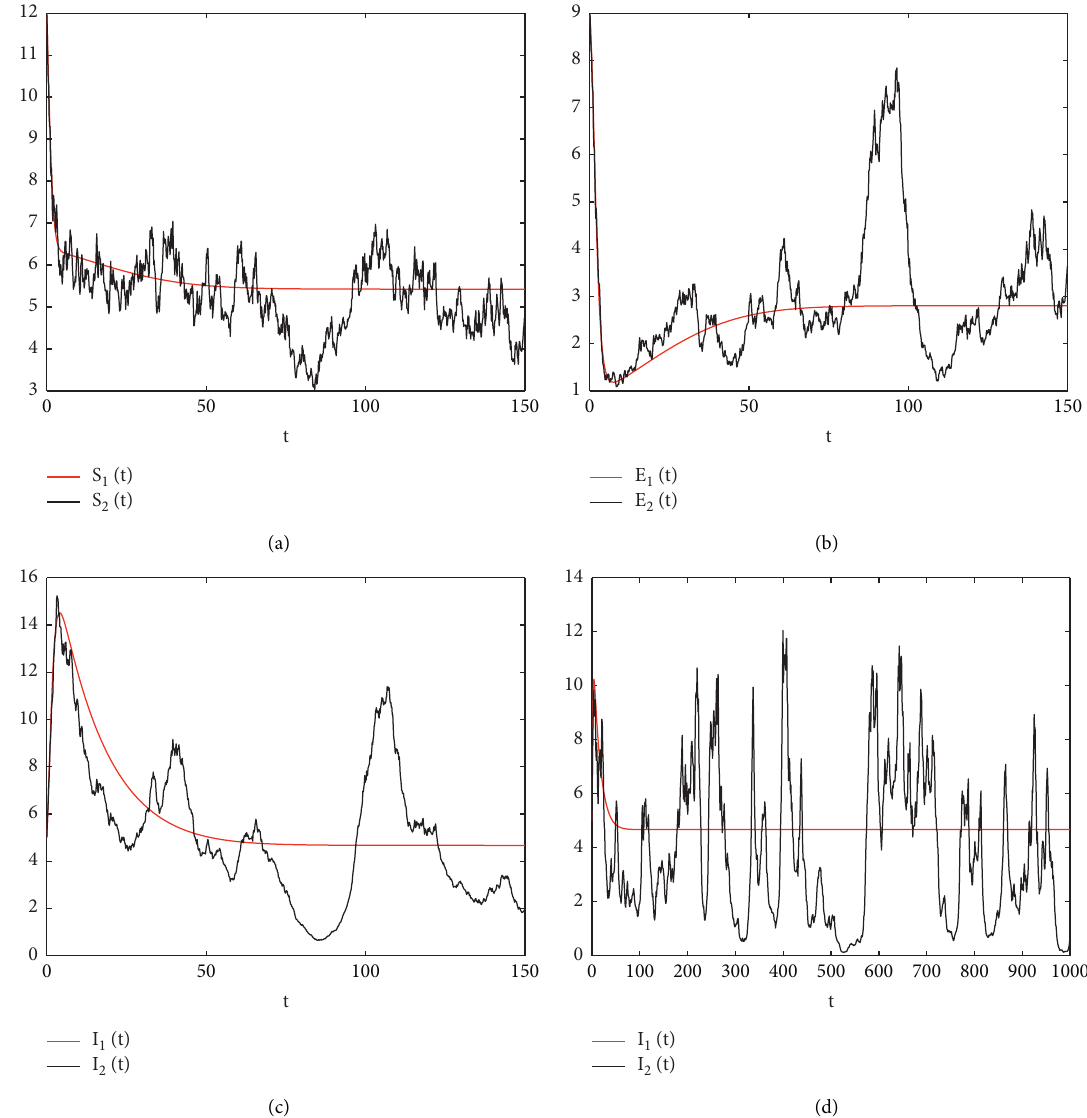
( t ) , E ( t ) ,I ( t ) is the solution to the stochastic model (2). 2 2 2